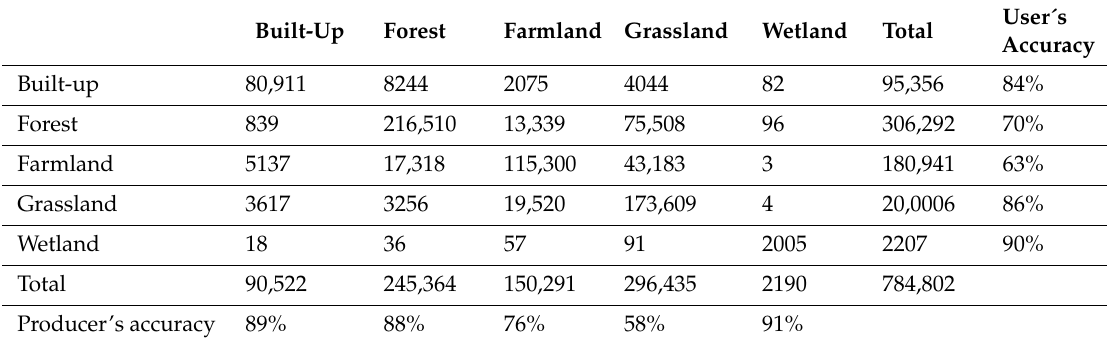
Table 7. Cross tabulation of actual (columns) against simulated (rows) LULC for 2018.